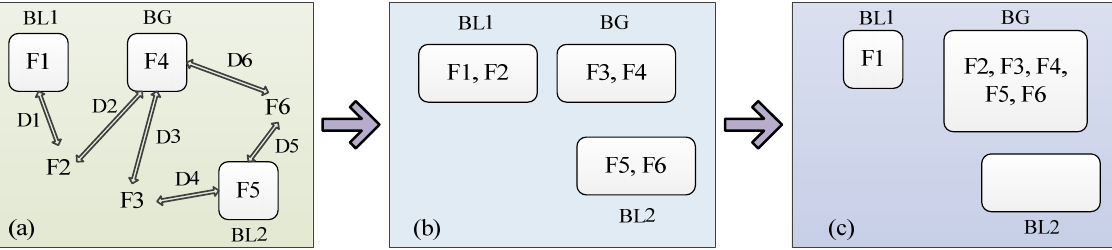
Figure 5. Three stages of FA: ( a ) the initial stage of the search; ( b ) the intermediate stage; ( c ) the final stage.